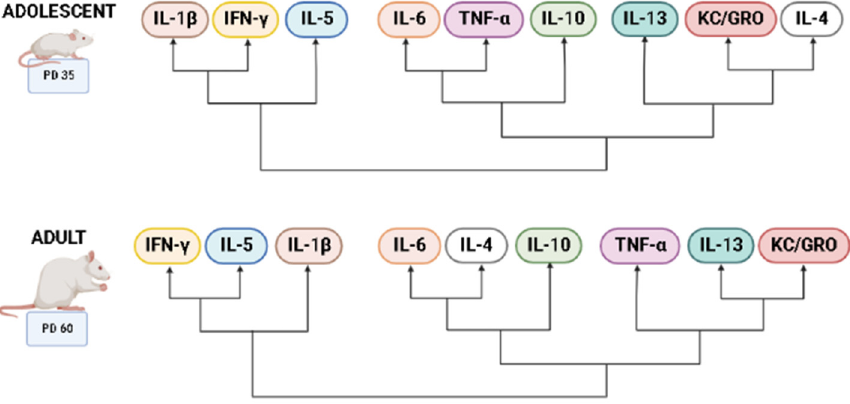
Figure 4. Dendrograms of cytokine grouping during adolescence and adulthood. Cytokine clustering shows similarities in adolescence and adulthood, despite differential cluster of groups within each age. Created using BioRender.com.